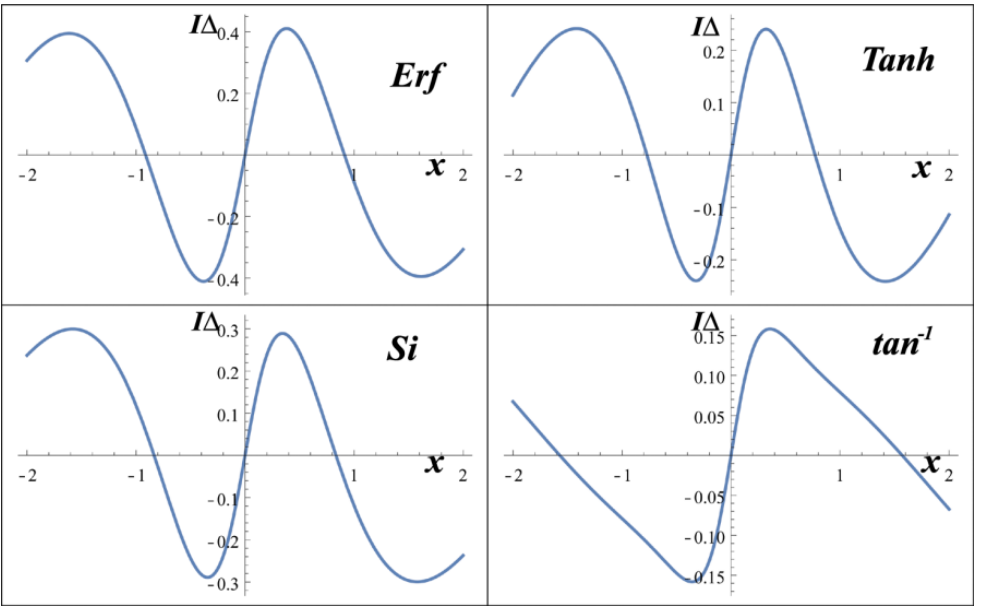
Fig. 3 The difference I ∆ between the numerical Br/Lr and the equivalent curves, integrated for the first